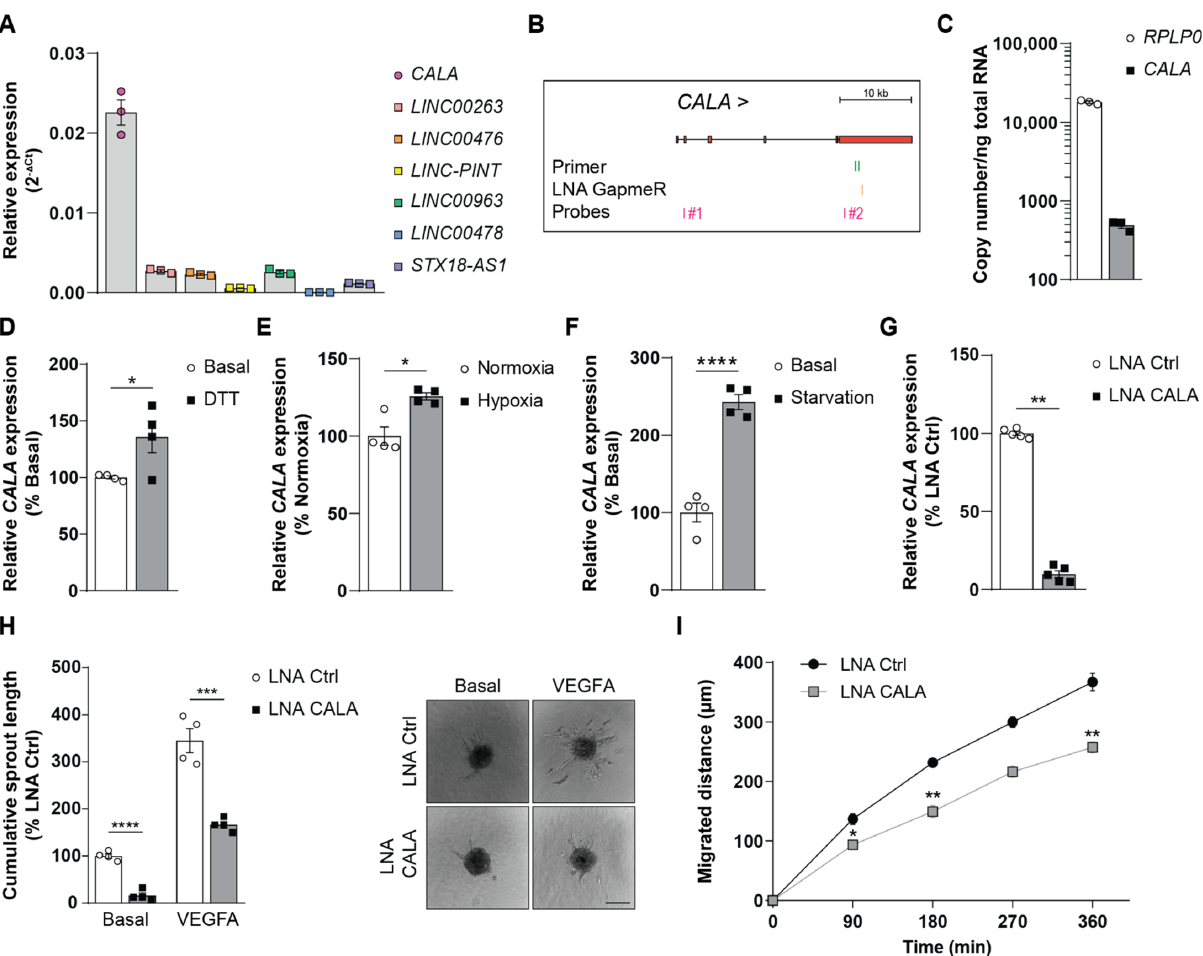
Figure 1. Stimuli-responsive lncRNA CALA regulates endothelial sprouting and migration. ( A ) Relative expression of CALA and indicated lncRNAs in HUVECs determined by RT-qPCR (n = 3). ( B ) Scheme of CALA highlighting primers, LNA GapmeR, and probes used. ( C ) Absolute quantifica- tion of CALA in HUVECs by digital RT-PCR (n = 3). ( D – F ) Relative CALA expression in HUVECs upon ( D ) ER stress (2 h, 1 mM DTT, n = 4), ( E ) hypoxia (24 h, 0.2% O 2 , n = 4), ( F ) starvation (reduced-serum media, 24 h, n = 4) compared to respective controls. ( G ) CALA expression after LNA-mediated silencing in HUVECs determined by RT-qPCR (n = 5). ( H ) Cumulative in vitro sprout- ing length of control and CALA -silenced HUVECs under basal conditions and VEGFA stimulation (n = 4). Representative pictures shown (scale bar = 100 µ m). ( I ) Migratory capacity of HUVECs upon CALA silencing compared to controls (n = 3). Data information: In ( A , C – I ) data are repre- sented as means ± SEM and derive from independent biological replicates, * p < 0.05, ** p < 0.01, *** p < 0.001, **** p < 0.0001. ( D , F , G , I ): two-tailed unpaired t -test, ( E ): Mann-Whitney U test, ( H ): two-way